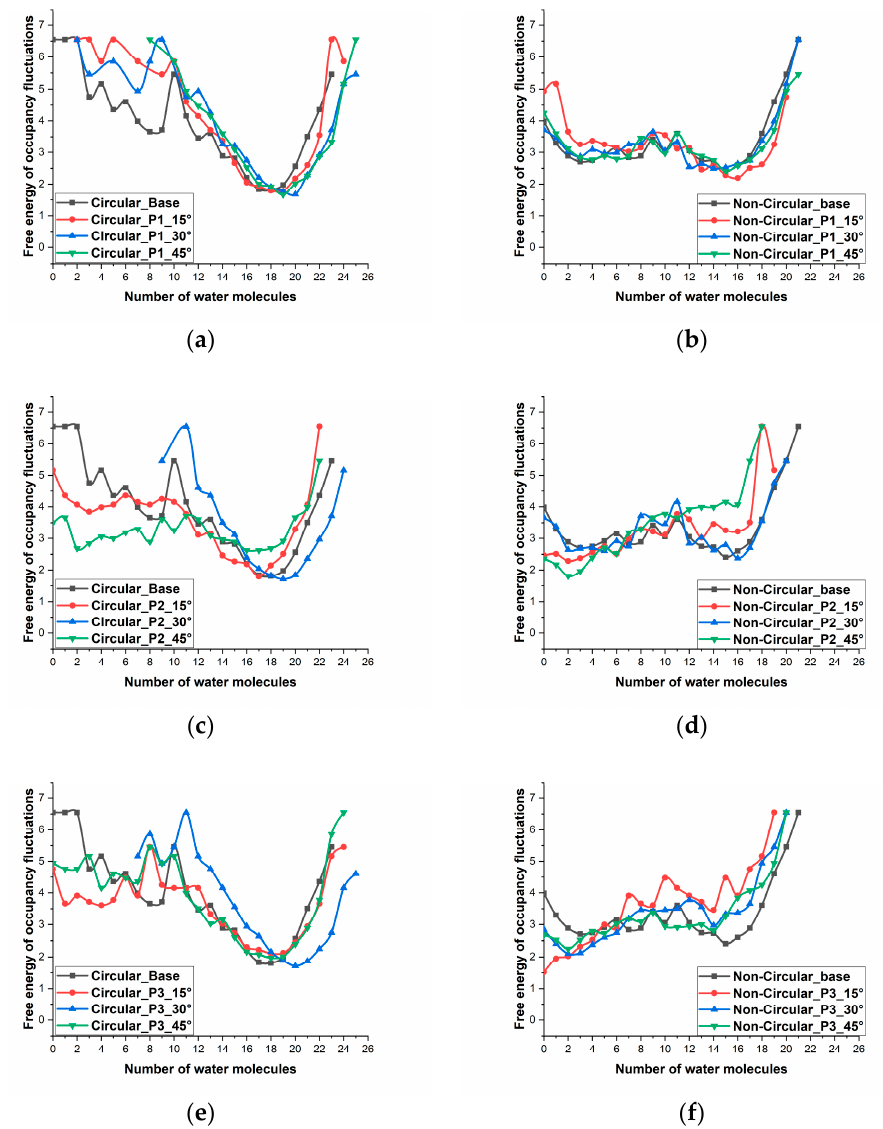
Figure 4. Free energy of occupancy fluctuations of water molecules inside the nanopore ( a ) circular pore with pattern 1 ( b ) Non-circular pore with pattern 1 ( c ) circular pore with pattern 2 ( d ) Non- circular pore with pattern 2 ( e ) circular pore with pattern 3 ( f ) Non-circular pore with pattern